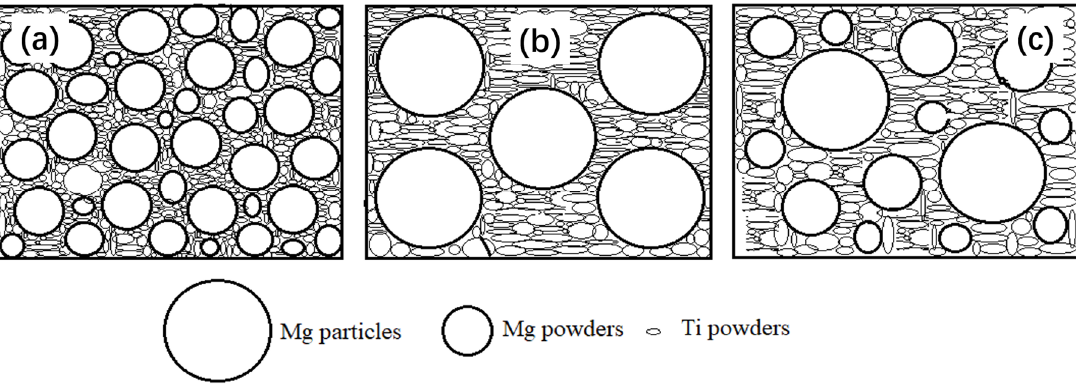
Figure 5. Schematic diagram of the mixed Ti powders, Mg powders and Mg particles in the green compact; ( a ) mixture of Ti powders and Mg powders, ( b ) mixture of Ti powders and Mg particles, ( c ) mixture of Ti powders, Mg powders and Mg particles.